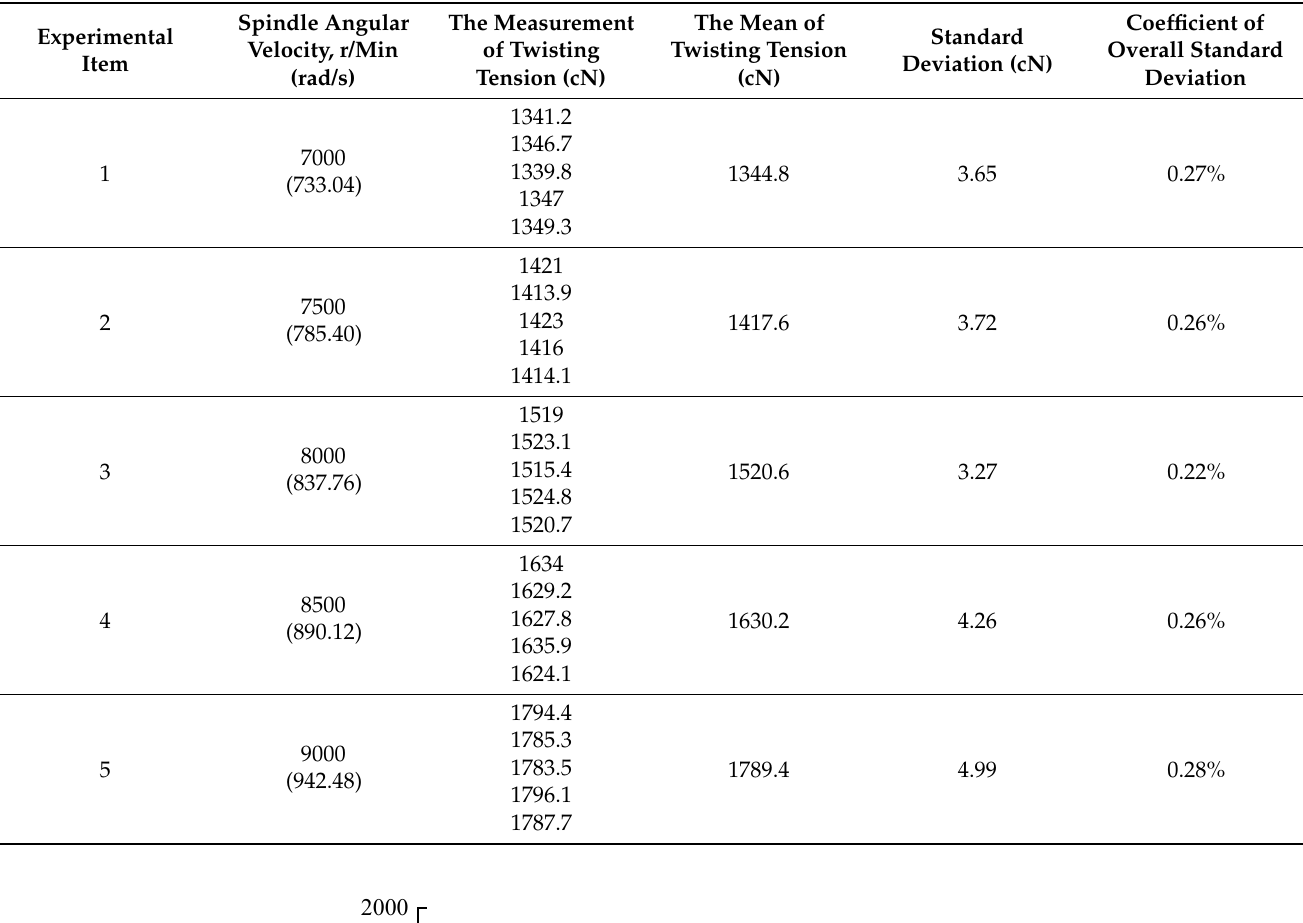
Table 1. Tension measurement results and standard deviation analysis of different spindle angu- lar velocity.